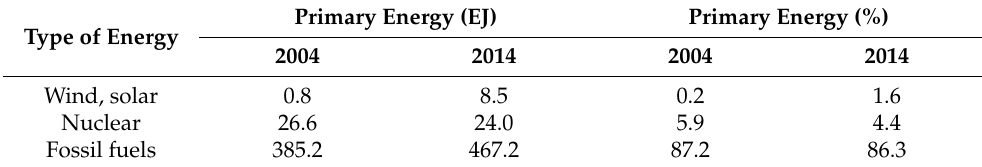
Table 2. Global primary commercial energy by type, 2014 [104].